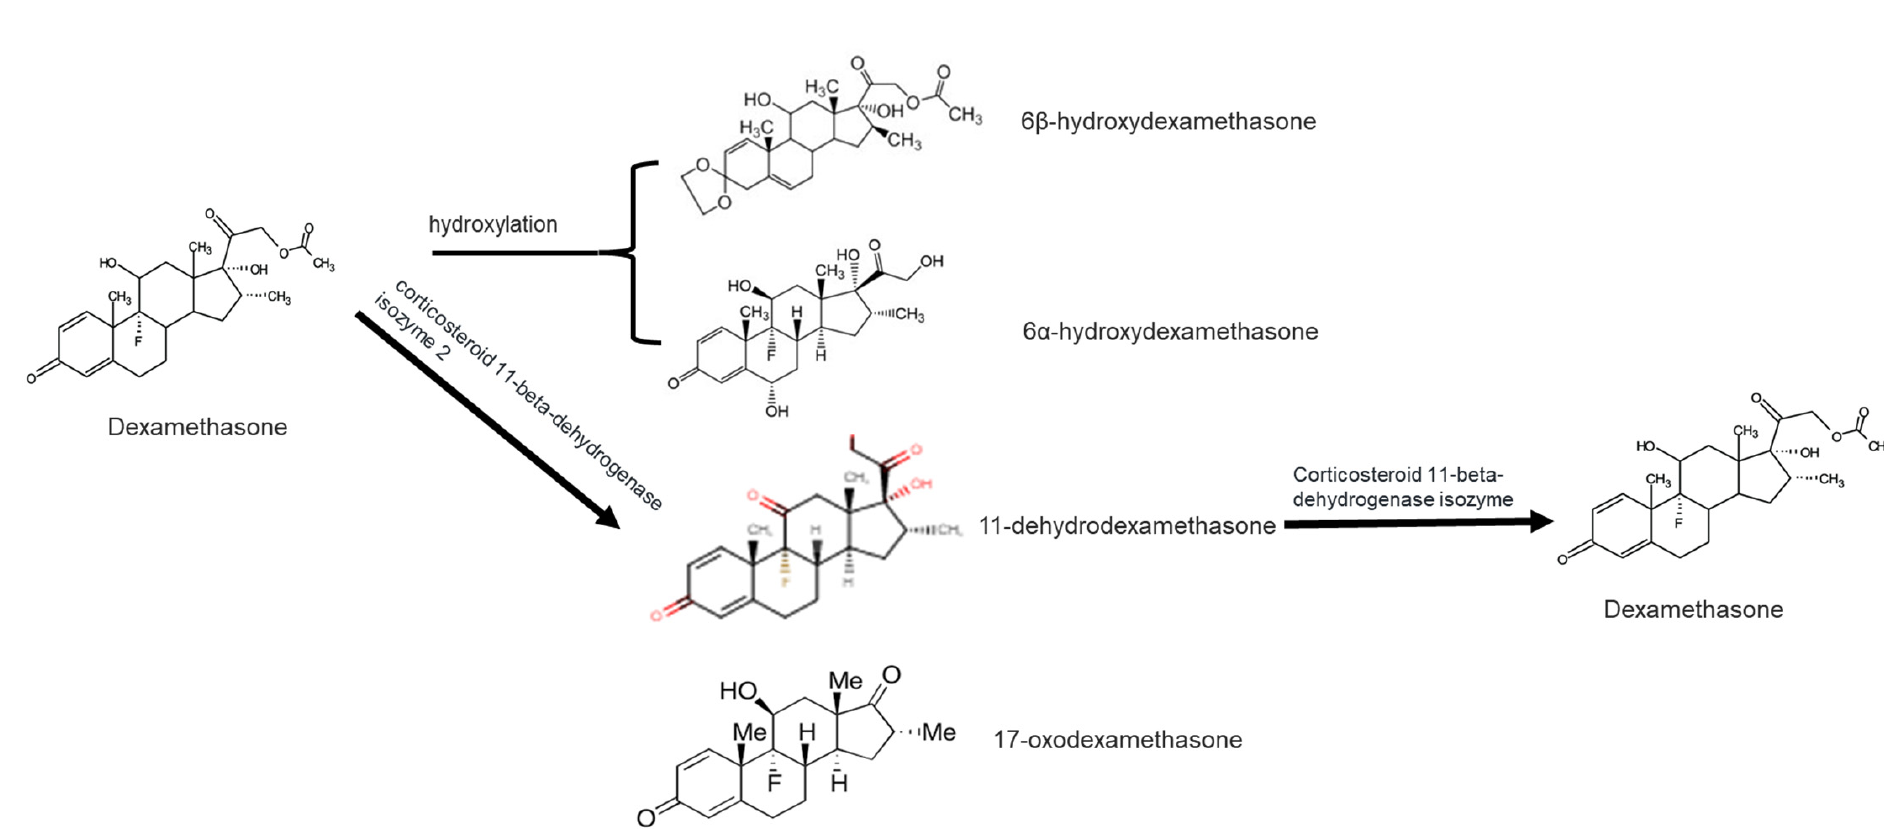
Figure 1. Structure of dexamethasone and formation of likely transformation products based on the dominant process in a given environment.